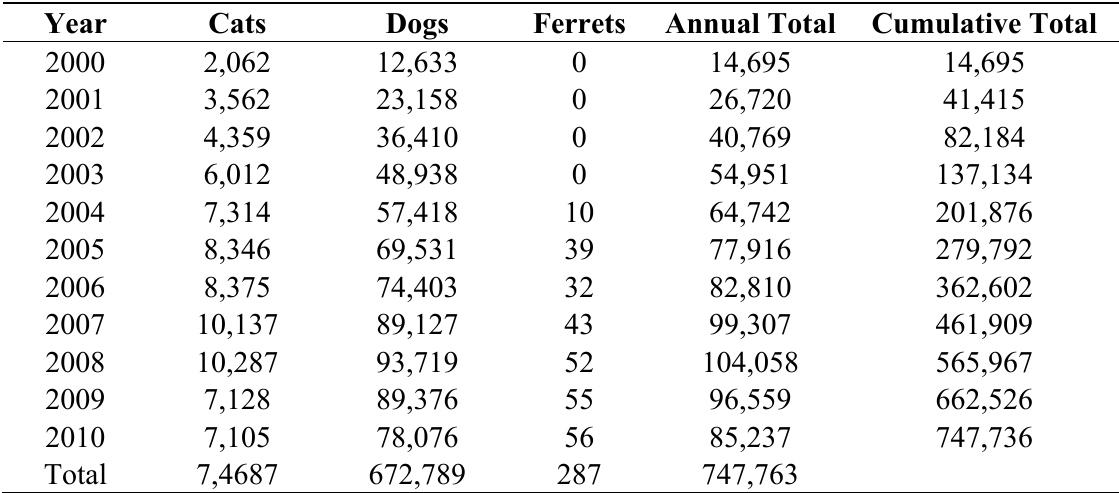
Table 2. Dogs, cats and ferrets entering the UK under the PETS Travel Scheme between 2000 through 2010 (Data published by Defra,